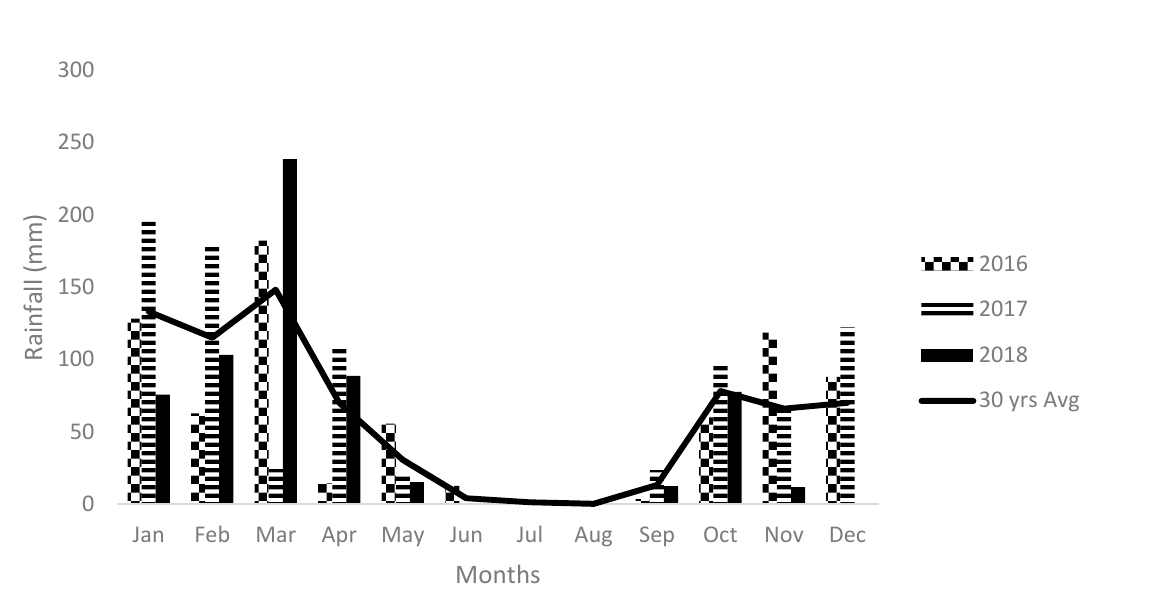
Figure 2. Experimental design: ( a ) 0% rainfall reduction, ( b ) 15% rainfall reduction, ( c ) 30% rainfall reduction and ( d ) 60% rainfall reduction.